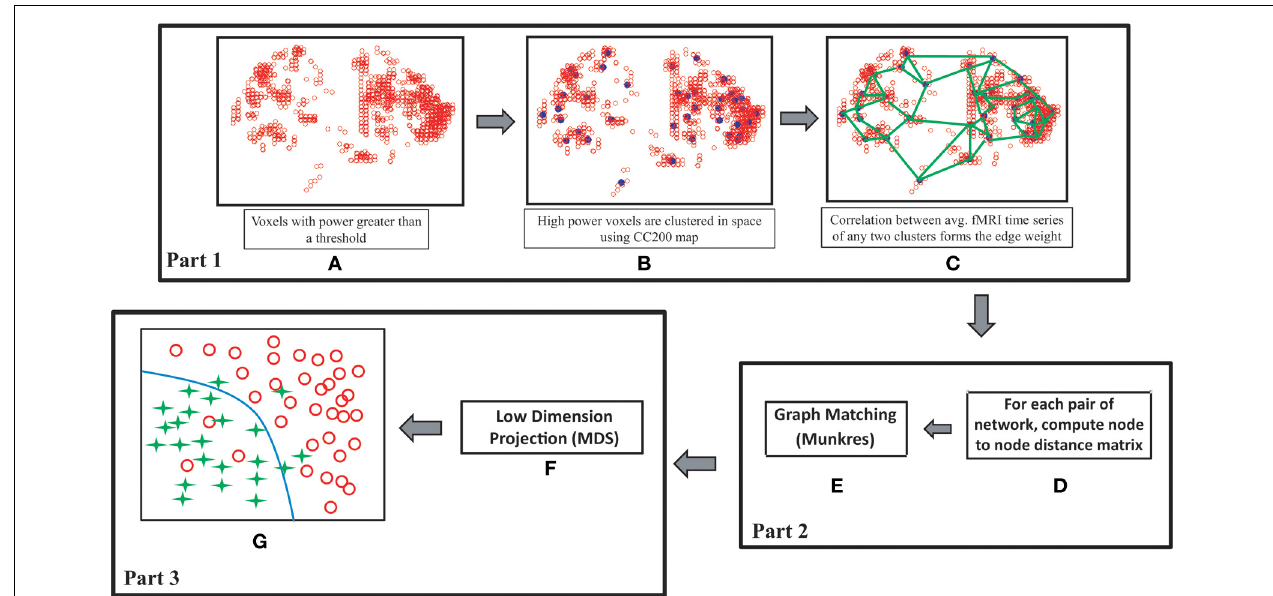
FIGURE 1 | Flowchart of our proposed method. (A) High power voxels are selected, (B) voxels belong to each region of interest of CC200 map are clustered together and represented by their cluster centers, (C) edges of the network are formed based on the correlations of average fMRI signals of the clusters, (D,E) inter network distances are computed in two steps. First, for a pair of networks a node to node distance matrix is